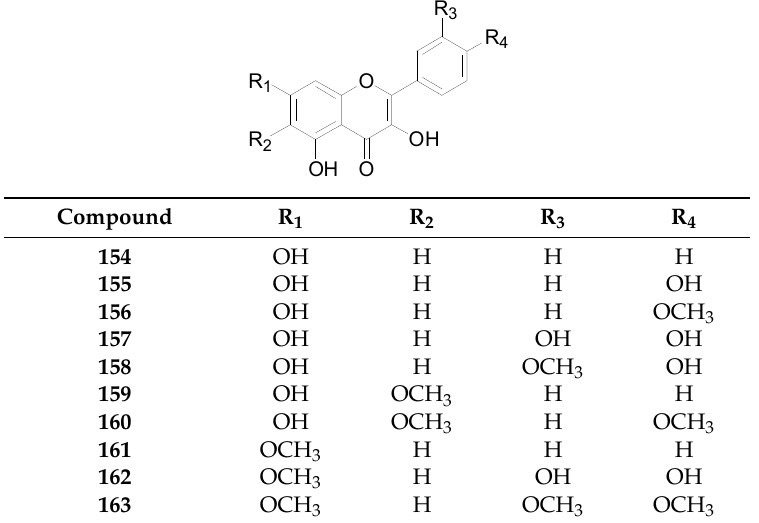
Table 10. Structures of compounds 154 – 163 .